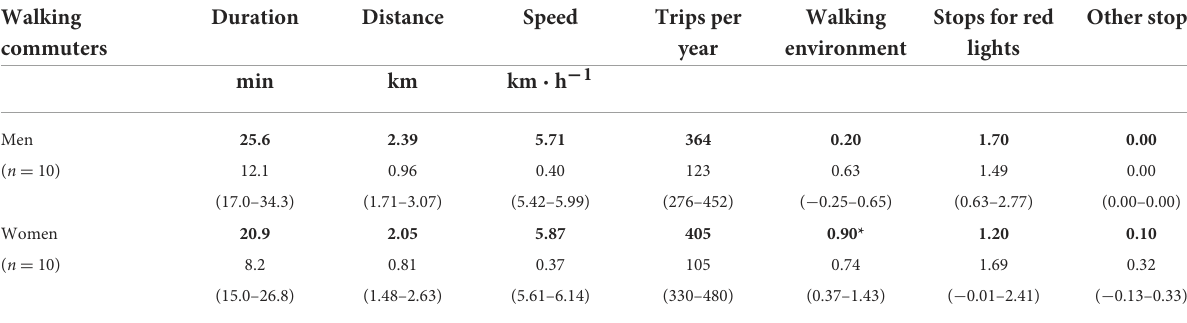
TABLE 5 Characteristics of trips, walking environments and stops for different reasons in walking commuting (mean, SD and 95% CI). Walking